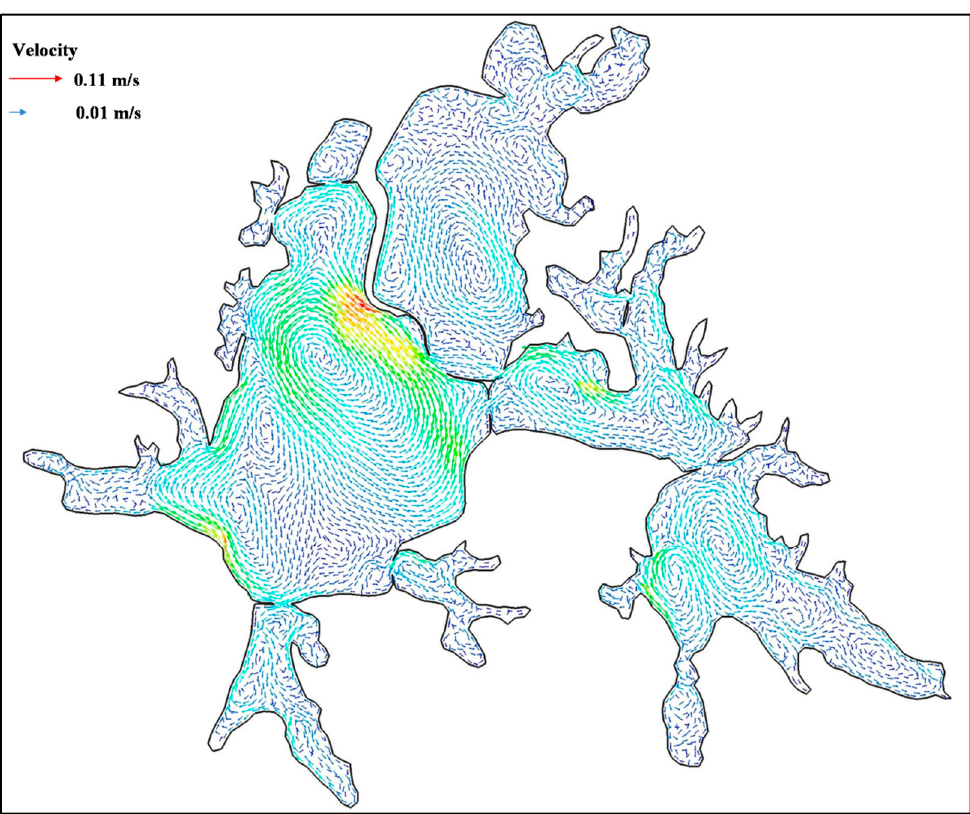
Figure 9. Simulated depth-averaged circulation on 5 July 2011.